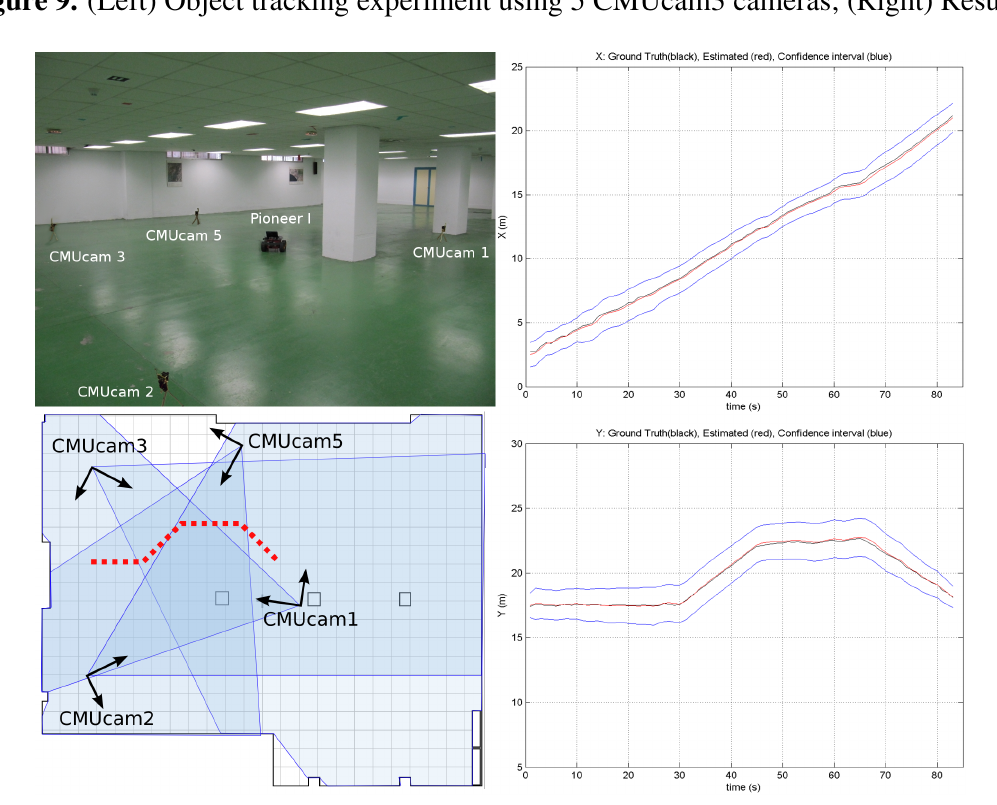
Figure 9. (Left) Object tracking experiment using 5 CMUcam3 cameras; (Right)